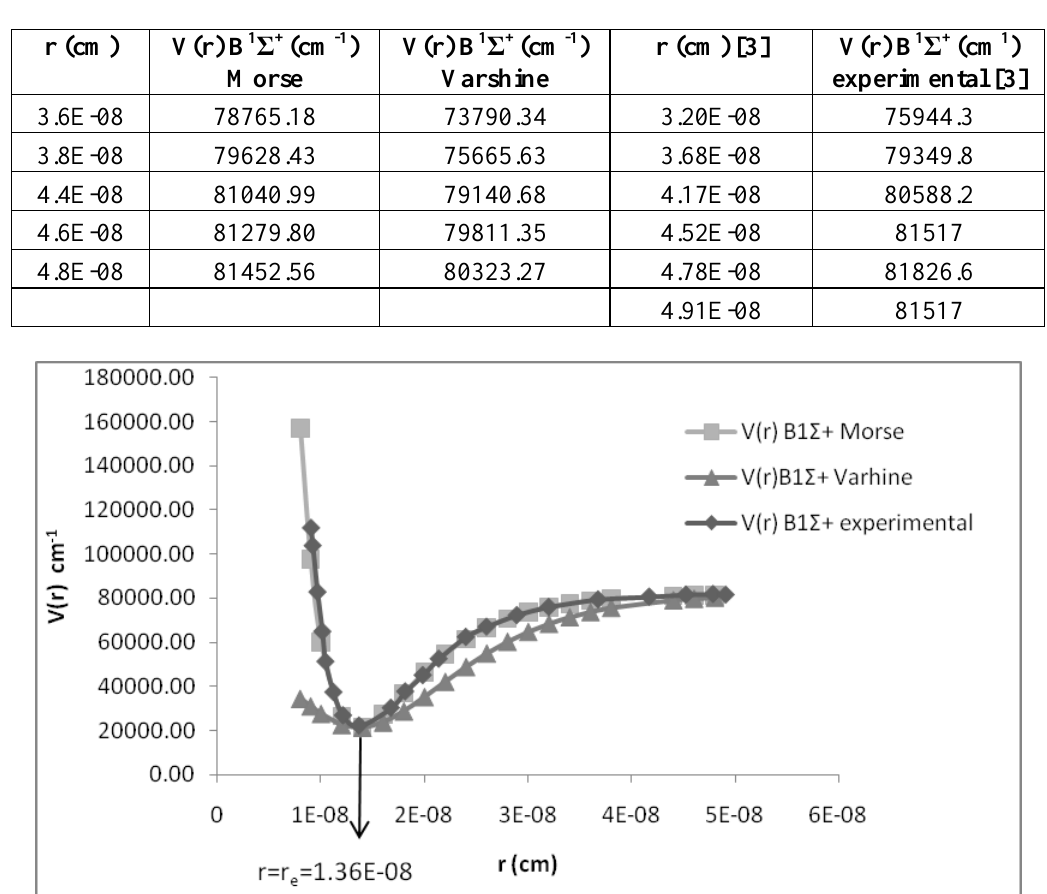
Fig.3: Theoretical potential calculated by Morse and Varshine function compare with the experimental curves for exited state B 1 Σ +